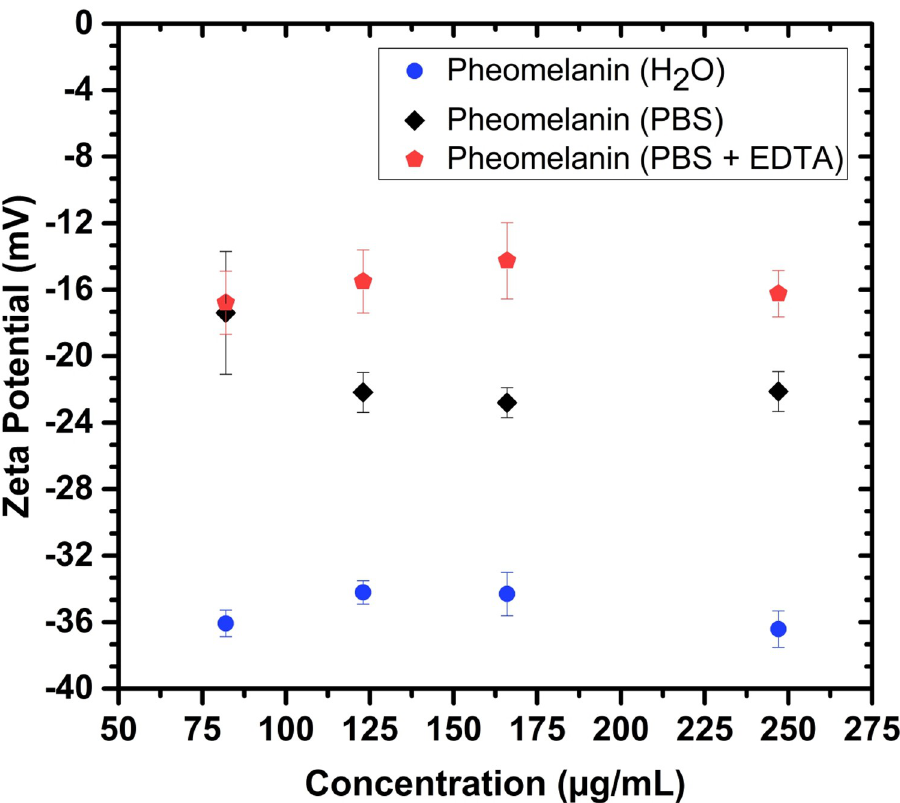
Fig 2. Zeta potential of pheomelanin nanoparticles as a function of concentration. Zeta potential of pheomelanin nanoparticles in different solvents: milli-Q water (blue), PBS (black) and PBS+EDTA (red), at 166 μ g/mL.